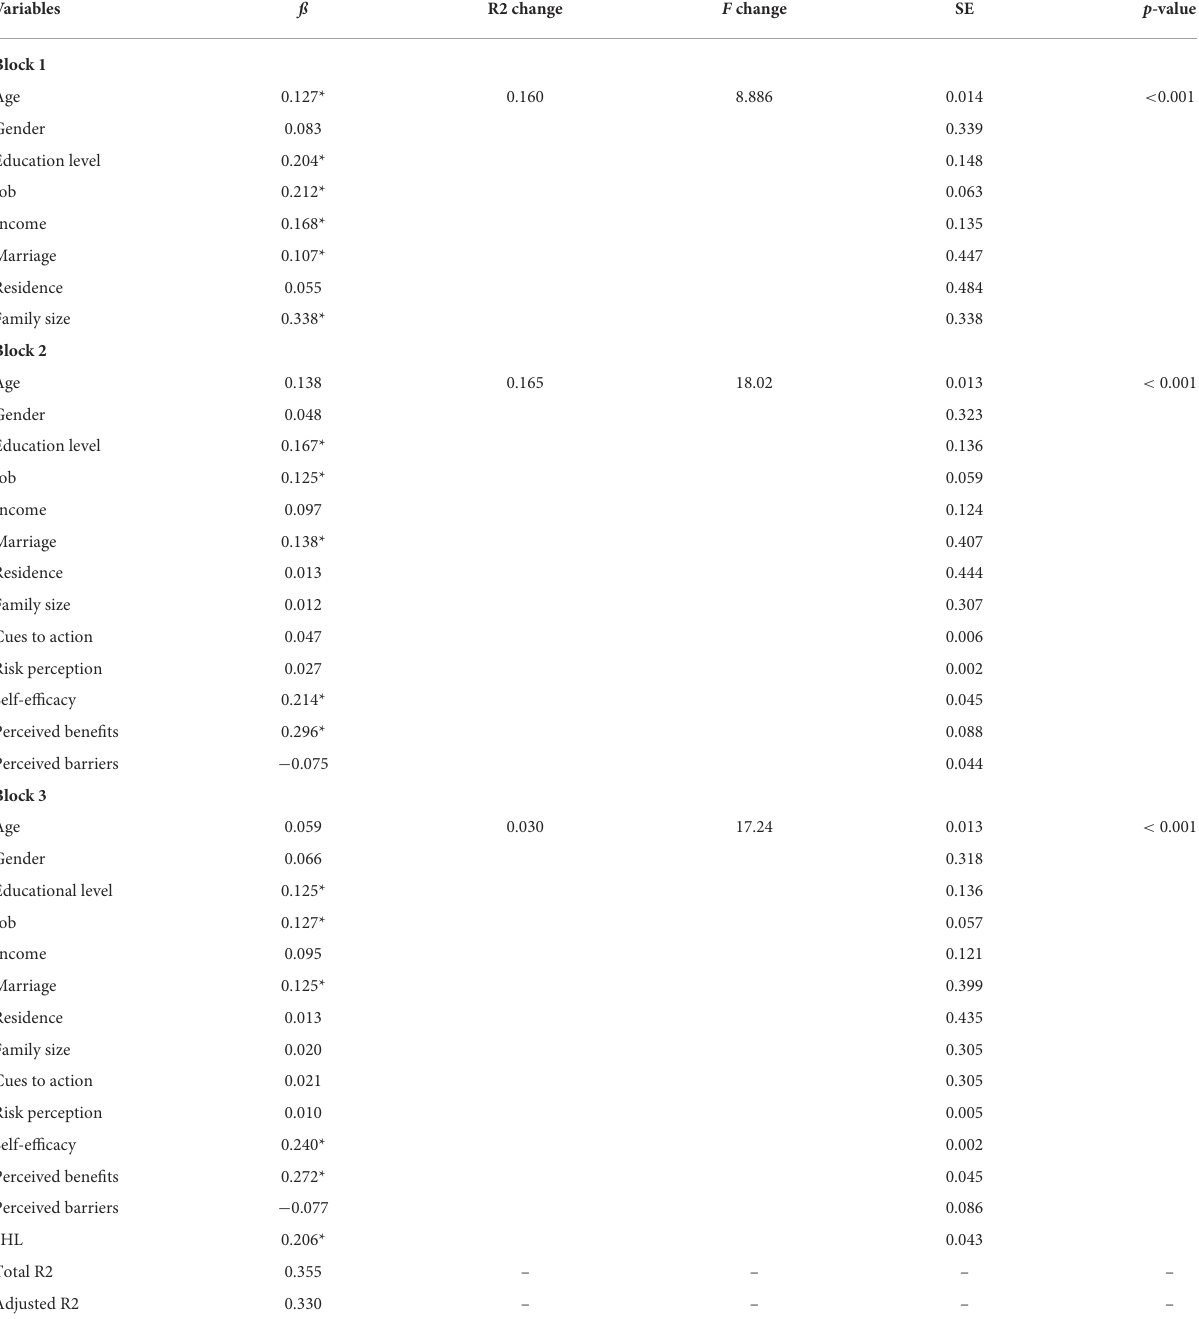
TABLE 3 Hierarchical linear regression for prediction of COVID-19 protective behaviors through demographic characteristics and eHL.